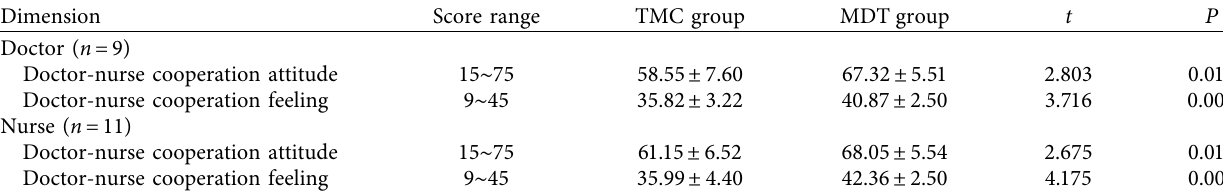
Table 5: Medical staf cooperation